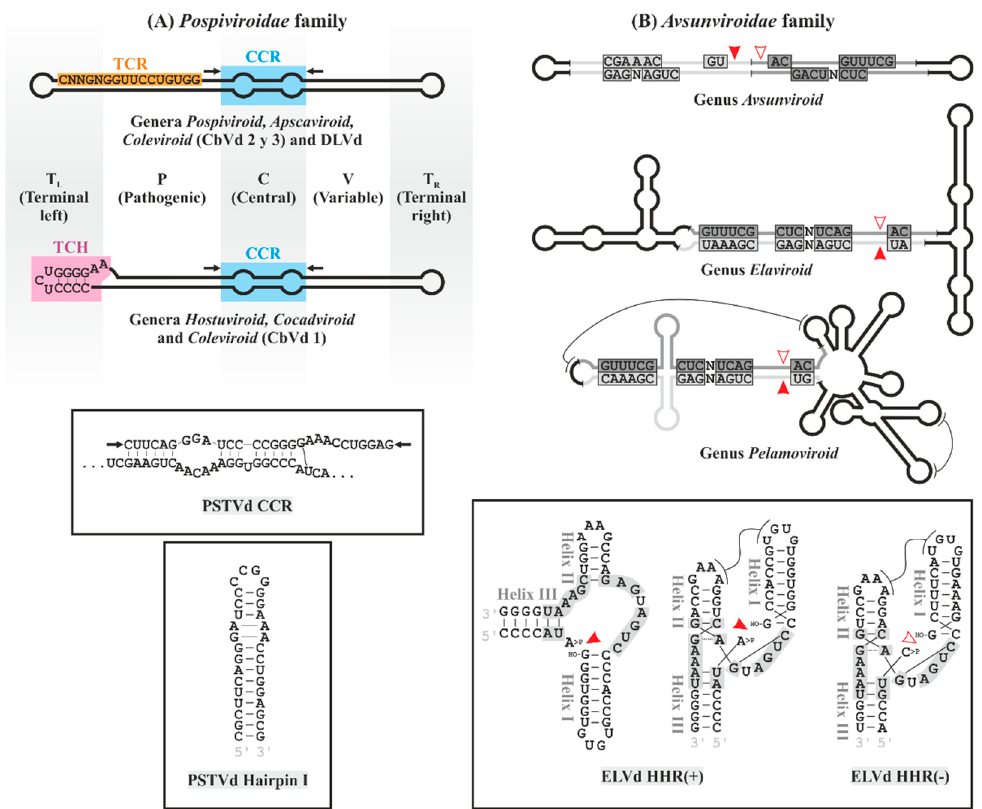
Figure 1. Structural characteristics of the viroids in the families Pospiviroidae and Avsunviroidae . ( A ) Members of the family Pospiviroidae adopt a rod-shaped secondary structure that has been functionally separated into five domains (TL, P, C, V and TR; differentially shaded). They contain conserved motifs: the features of the CCR (blue box) and the presence of TCR or TCH (orange and pink boxes, respectively) define the characteristics of each genus, as indicated. Together with the conserved sequence of the upper strand of the CCR, the flanking variable nucleotides (indicated by arrows) form an imperfect hairpin (hairpin I). Both the characteristic CCR sequence of PSTVd and the hairpin that forms are shown in the upper and lower inserts, respectively. ( B ) Avsunviroidae viroids adopt rod-shaped, branched or semibranched secondary structures (genus Avsunviroid, Pelamoviroid and Elaviroid , respectively). They contain conserved sequences of hammerhead ribozymes (HHR) that are functional in positive and negative strands (light and dark gray boxes, respectively, with the self-cleavage sites indicated by solid or empty arrowheads, respectively). In PLMVd, ‘kissing-loops’ tertiary interactions are indicated by lines. The insert includes the sequence of the HHR of ELVd with the classic representation that gives name to these ribozymes (left) next to the same HHR in both polarities according to the data of X-ray crystallography and NMR. Tertiary interactions between loops 1 and 2 are shown with lines. HO- and >P, 5 ′ -hydroxyl and 2 ′ ,3 ′ -phosphodiester groups, respectively; CCR, central conserved region; HHR, hammerhead ribozyme; N, any nucleotide; TCR, terminal conserved region; and TCH, terminal conserved hairpin.